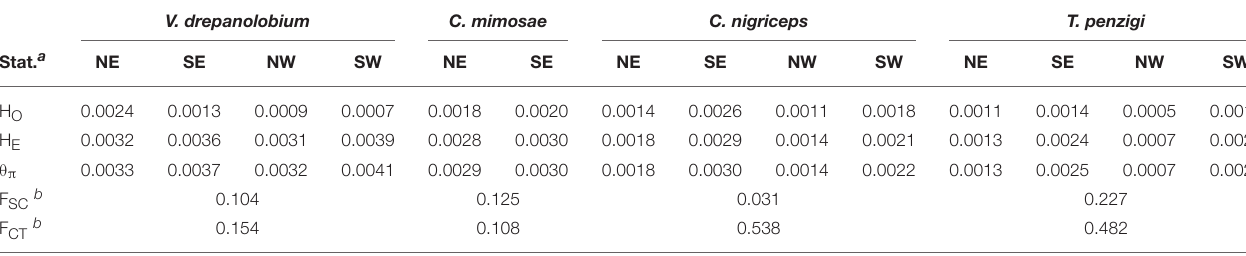
TABLE 4 | Population genetic summary statistics for each